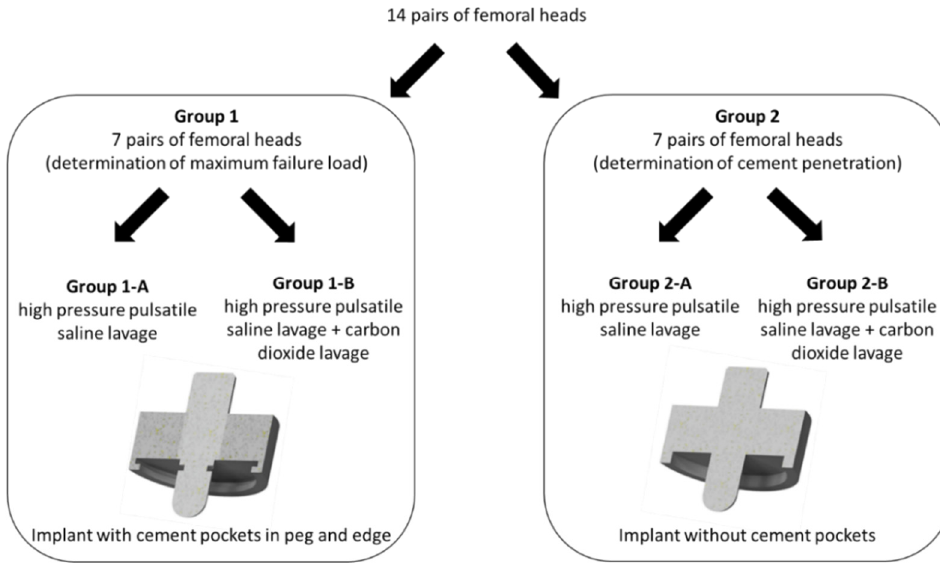
Figure 1. Distribution of the 28 femoral heads to the different cleaning procedures and different test implants for either determination of maximum failure load or cement penetration .